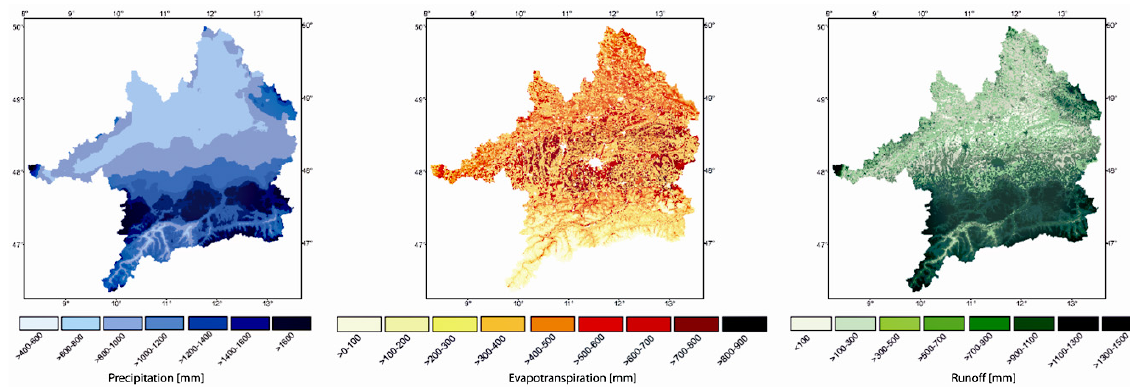
Figure 4. Modelled distributed water balance in the UDRB in using station recordings as meteorological drivers for the period 1971–2000.